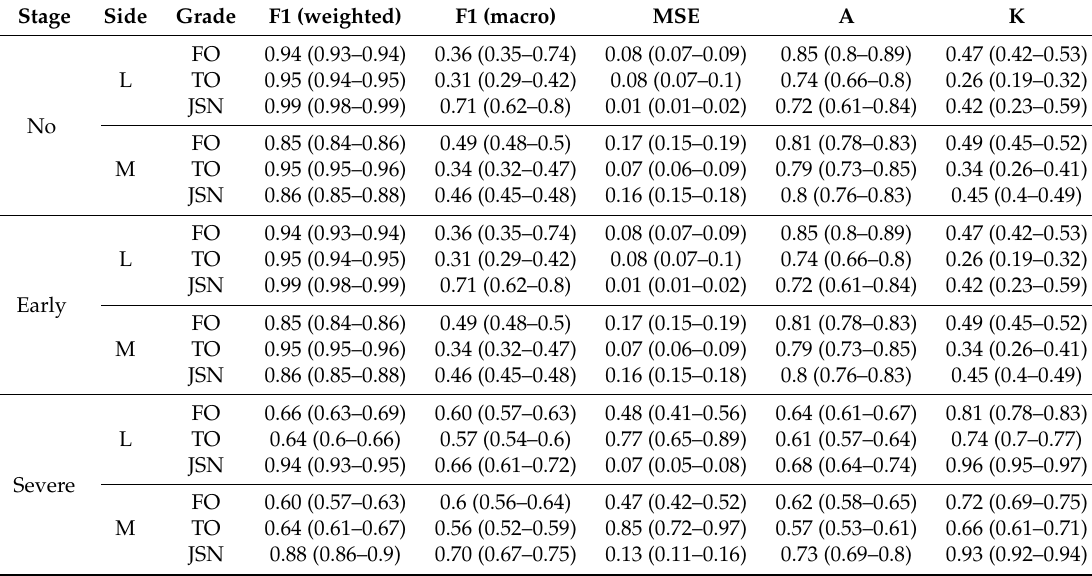
Table 4. Test set performance of our ensemble method with SE-Resnet50 and SE-ResNext50-32x4d backbones with respect to the stage of osteoarthritis. F1, MSE, A and K indicate F1-score (geometric average of precision and recall) either weighted by the support or by averaging F1 scores across the classes (macro averaging), mean squared error, balanced accuracy and Cohen’s kappa, respectively. L and M indicate lateral and medial compartments, respectively. FO and TO indicate femoral and tibial osteophytes and JSN indicates joint space narrowing, respectively. KL indicates the Kellgren–Lawrence grade. Here, “No OA” indicates knees with KL0 and KL1, “Early OA” indicates knees with KL2 and “End stage” indicates knees with KL3 and